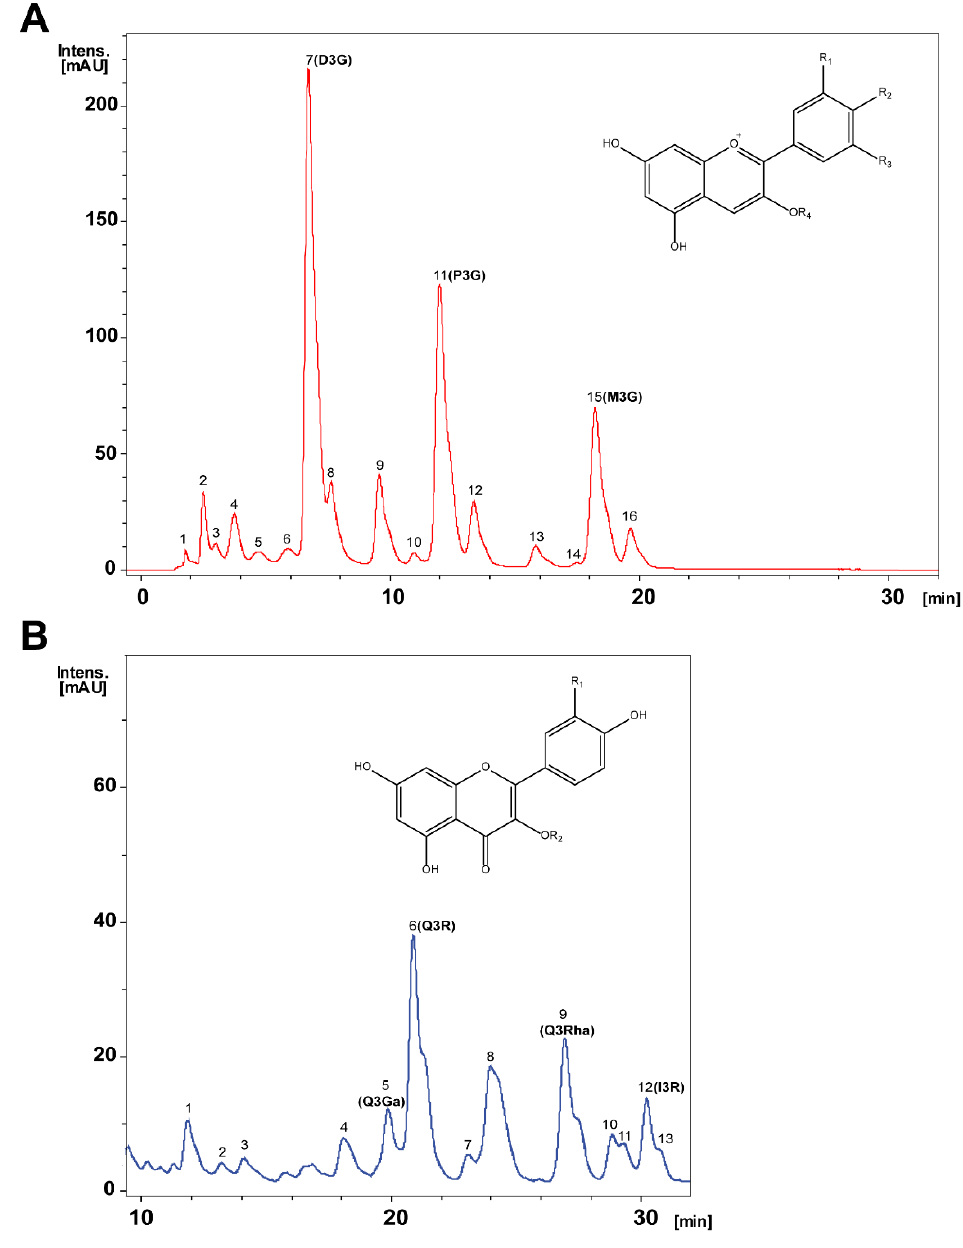
Figure 1. Representative chromatographic analysis of Calafate berry extracts. ( A ) Prototype anthocyanins chromatogram of the hydroalcoholic extract based on 520 nm absorbance. Sixteen major peaks were observed; mass spectra analysis of the peaks revealed the list of putative compounds shown in Table 1. Inset shows the basic anthocyanin structure; position 3 conjugations are referred to as R 4 substituents. ( B ) Representative chromatogram of hydroalcoholic extract flavonols identified by absorbance at 360 nm; the 13 major peaks identified and analyzed by mass spectrum are listed in Table 1. The basic flavonols structure and its glycosylated substituents in R 2 refer to the various sugar conjugates present in the extract.